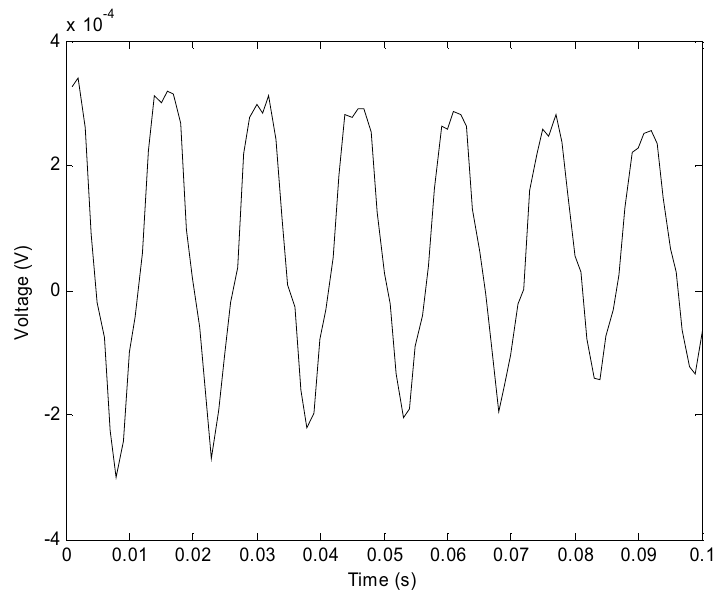
Fig. 17. PZT sensor voltage for the system rotating at 40 Hz. Rubbing is assumed at the tip of the blade where PZT sensor is mounted. PZT sensor voltage has captured frequency components at 40 Hz, 52 Hz and 340 Hz with more sensitivity to the 340 Hz component. This has occurred as the sensor efficiently reflects the motion at the blade